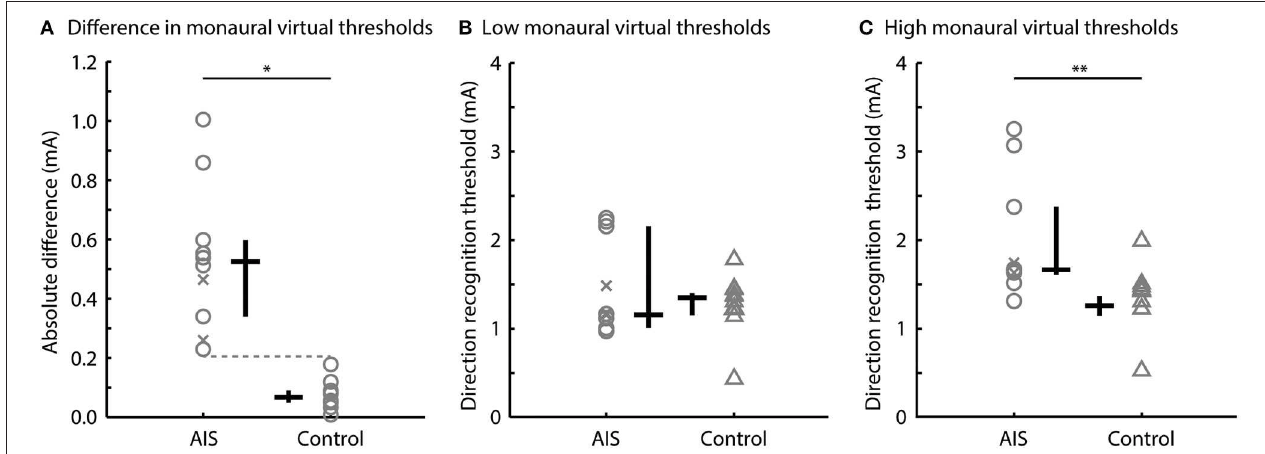
FIGURE 3 | Direction recognition thresholds to monaural virtual rotations. Comparisons of (A) the absolute differences in left and right direction recognition thresholds, (B) the low direction recognition thresholds, and (C) the high direction recognition thresholds between the AIS and control subjects. Gray markers show individual data; black bars show the median and interquartile range. Post-surgery subjects are shown by the x markers (* p < 0.001; ** p < 0.01).